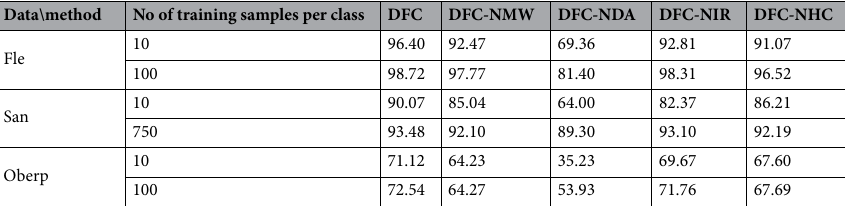
Table 7. A brief comparison of overall classification accuracy for different cases of DFC method.